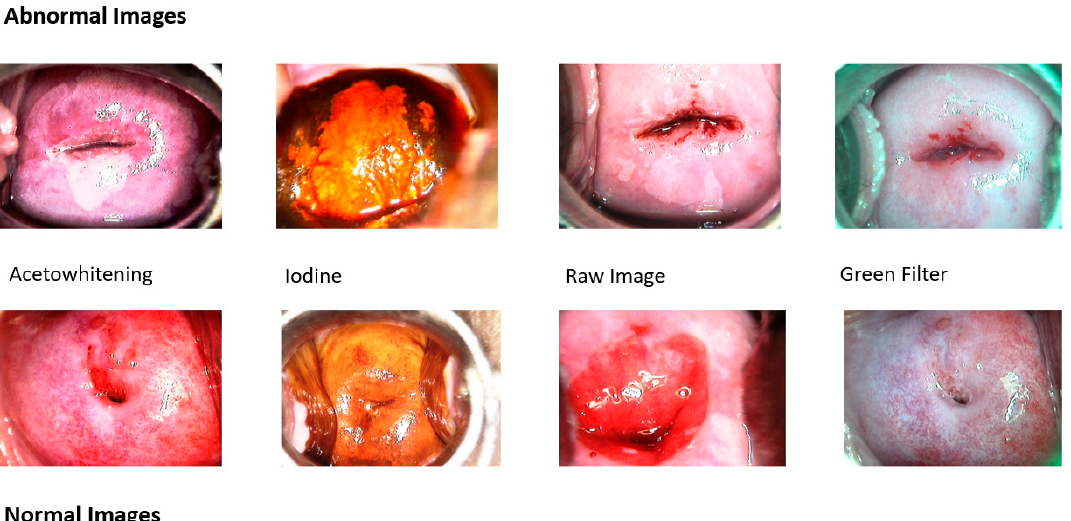
Figure 2. Sample images in the dataset for normal and abnormal classes—both classes have images of aceto-whitening, iodine, raw image, and green filter.